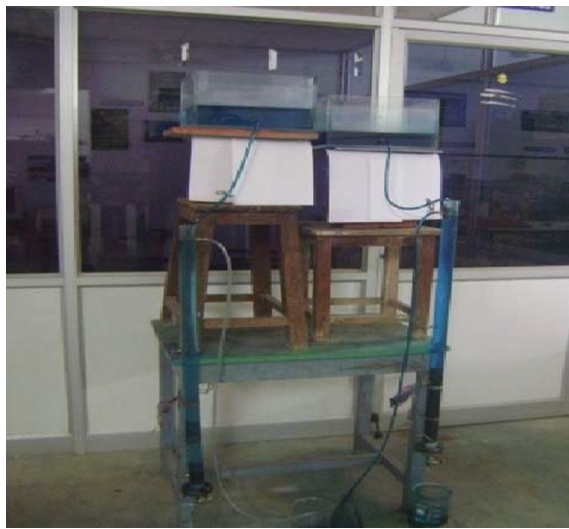
Figure 2: Fixed-bed